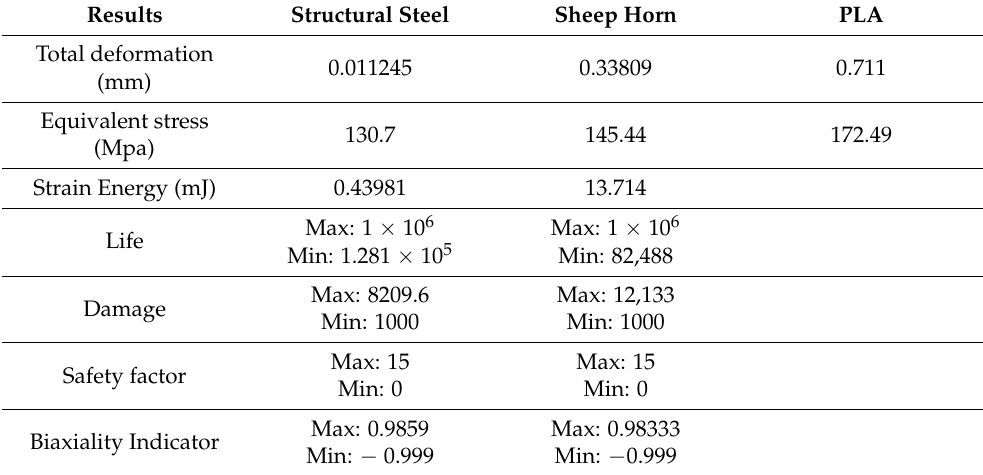
Table 6. Simulation study comparison for horn structure.